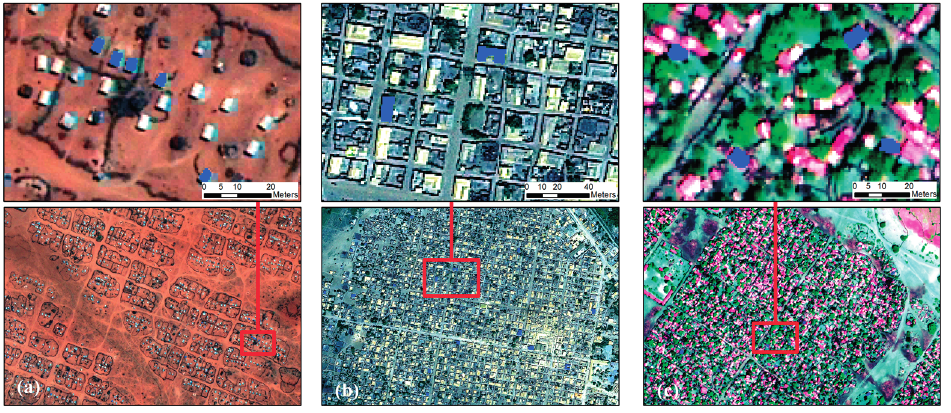
Figure 8. The datasets used for method evaluation, namely ( a ) Bokolmanyo; ( b ) Jowhaar and ( c ) Hagadera. The blue polygons in the enlarged subsets represent digitized reference